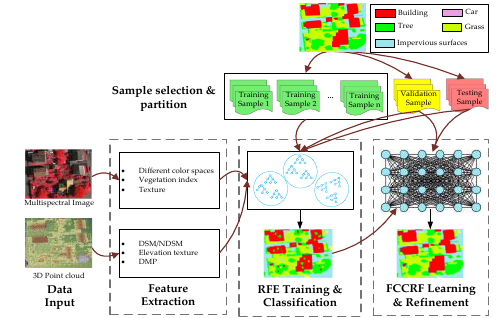
Figure 1. Pipeline of the proposed classification